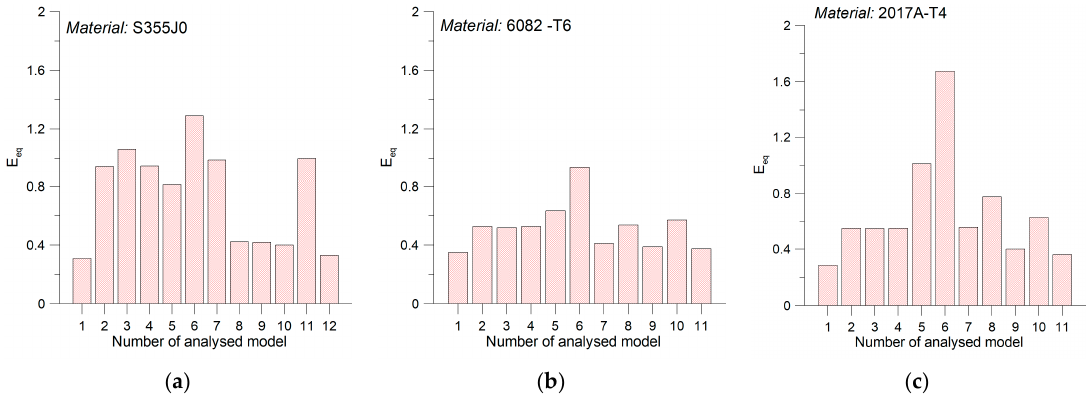
Figure 6. Average scatter bands E eq for materials ( a ) S355J0; ( b ) 6082-T6; ( c ) 2117A-T4 for the analyzed models: 1. Kluger- Ł agoda; 2. Matake; 3. Findley; 4. Dang Van; 5. Papadopoulos; 6. Smith-Watson- Topper; 7. McDiarmid; 8. Carpinteri-Spagnoli; 9. Goodman; 10. Gerber; 11. Soderberg; 12. Pawliczek- Gasiak.